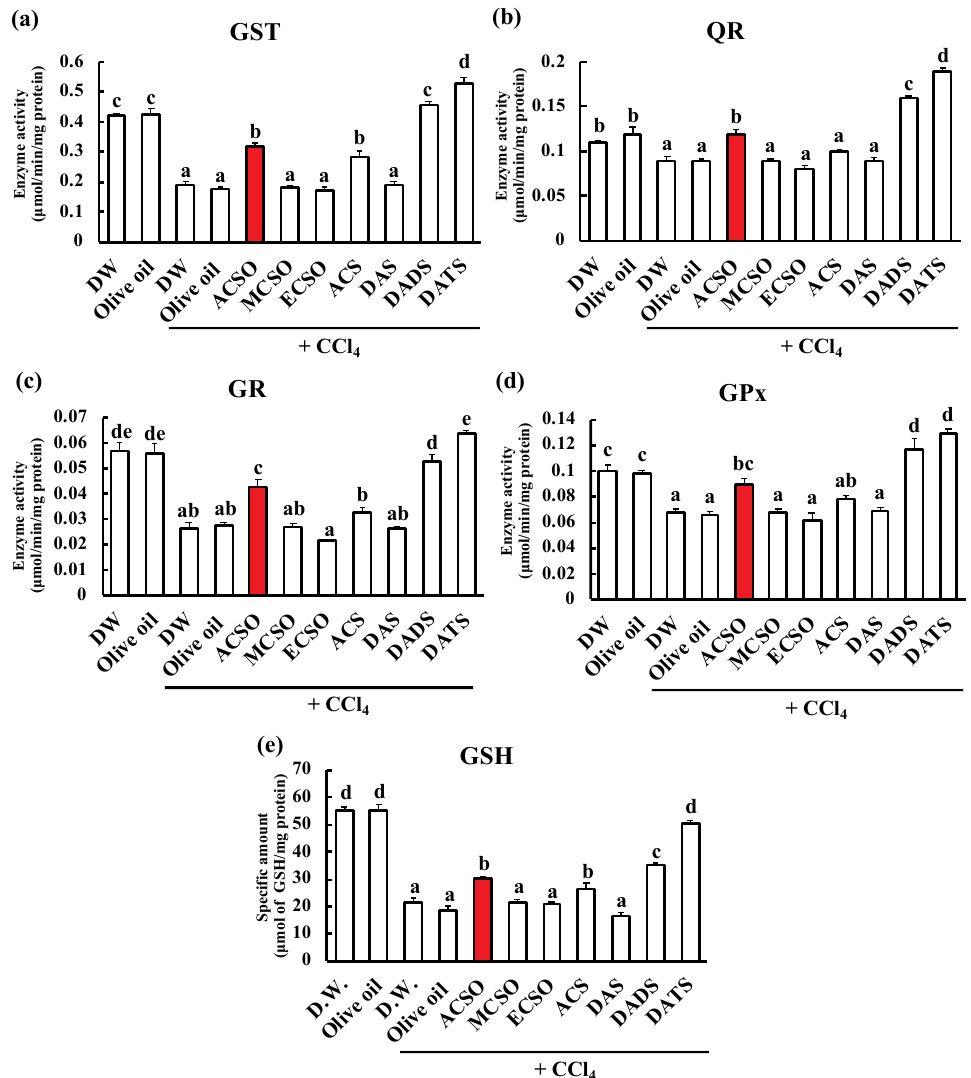
Figure 4. Effect of ACSO, its analogs, and garlic-odor compounds on Phase II and antioxidative enzyme activities and glutathione (GSH) content. Enzymatic activities of ( a ) glutathione- S -transferase (GST), ( b ) quinone reductase (QR), ( c ) glutathione reductase (GR), ( d ) glutathione peroxidase (GPx), and ( e ) GSH, in the livers of rats with CCl 4 -induced hepatic injury. Each value represents the mean of six rats ± S.E. The different letters in the figures indicate a significant difference between the groups ( p < 0.01).